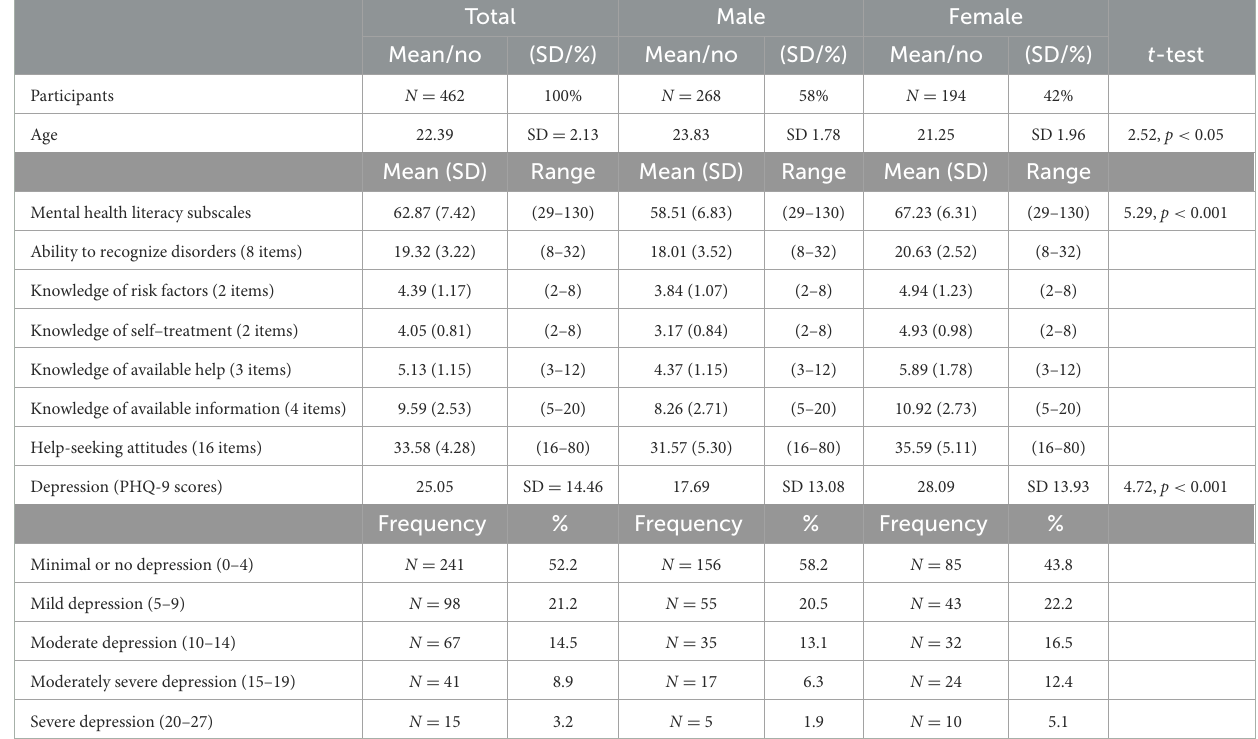
TABLE 1 Socio-demographic characteristics, mental health literacy and depression among study participants.